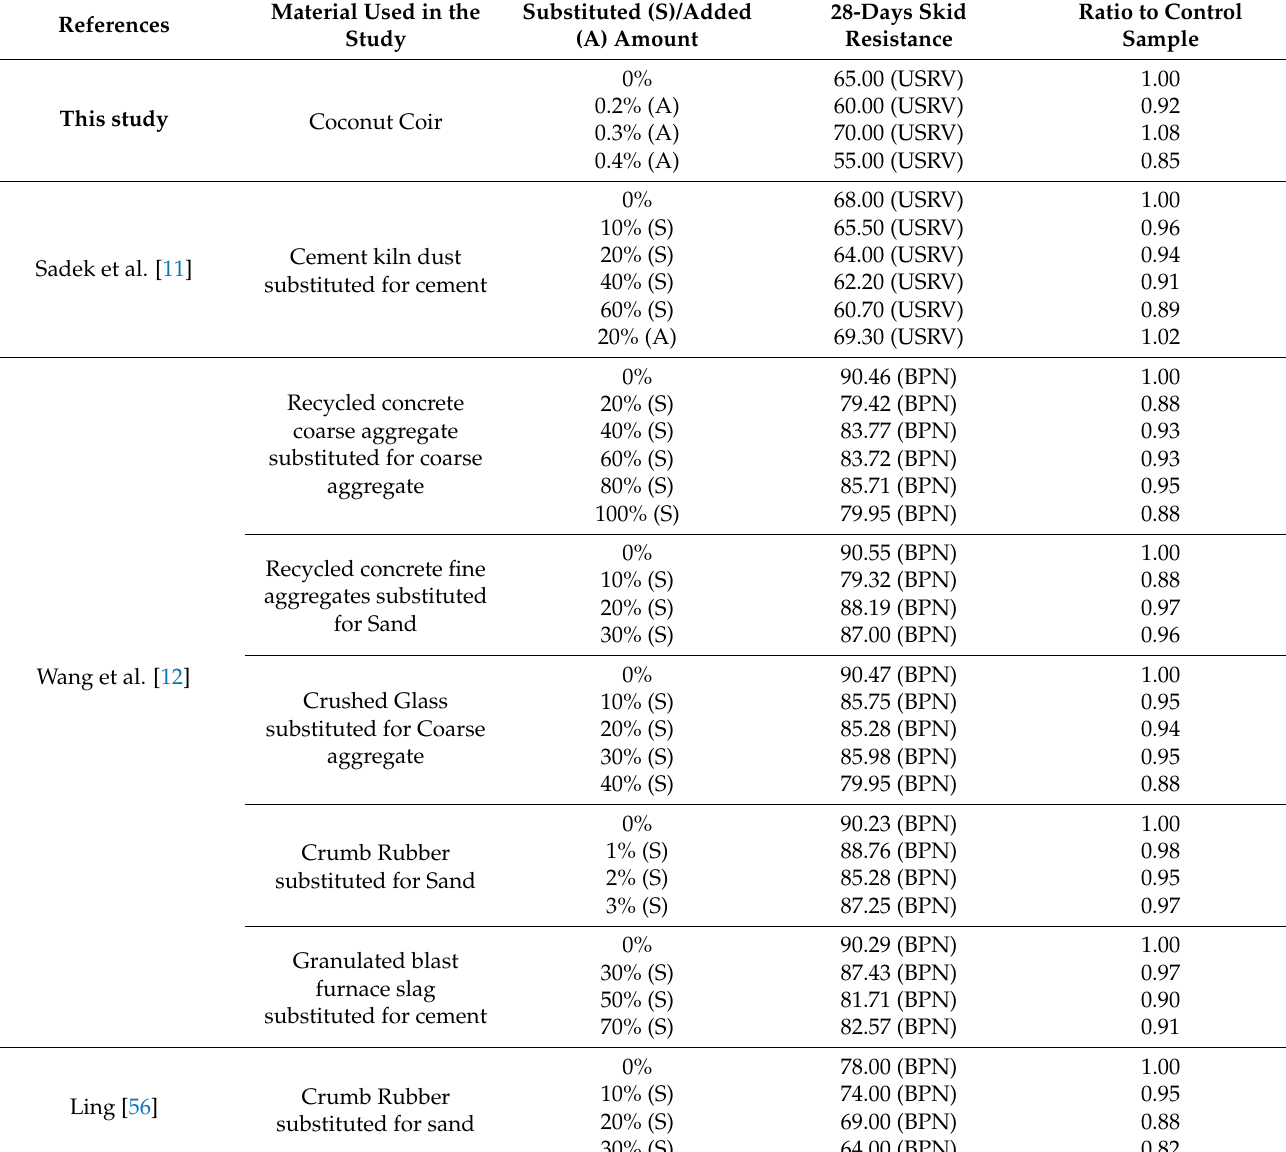
Table 12. Comparison of Skid resistance of IPB with various